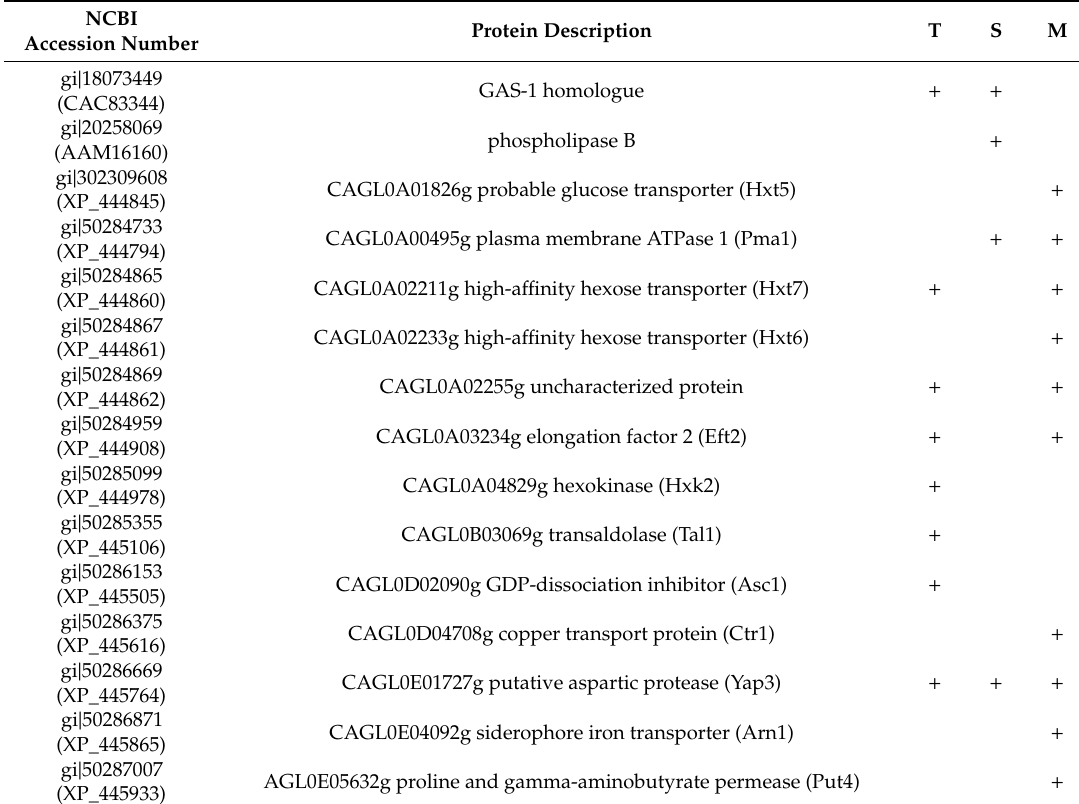
Table 3. Mass spectrometry identification of abundant proteins in C. glabrata EVs after vesicle surface shaving with trypsin (T) or vesicle sonication (S), and in EV membrane protein-enriched fractions (M). The peptides obtained were analyzed using the Dionex Ultimate 3000 UHPLC system coupled to an HCTUltra ETDII mass spectrometer and the obtained lists of peaks were searched against the NCBI protein database using an in-house Mascot